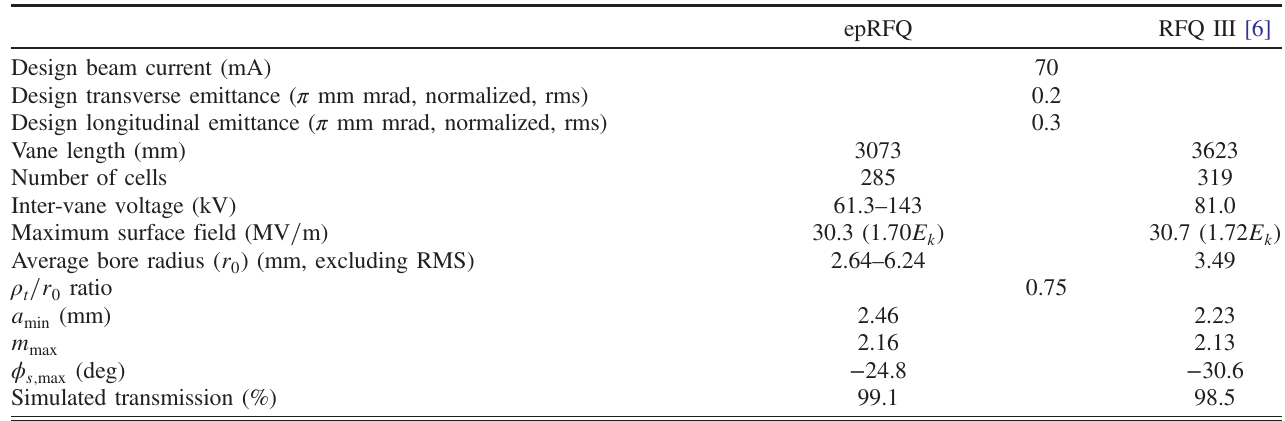
Simulated transmission